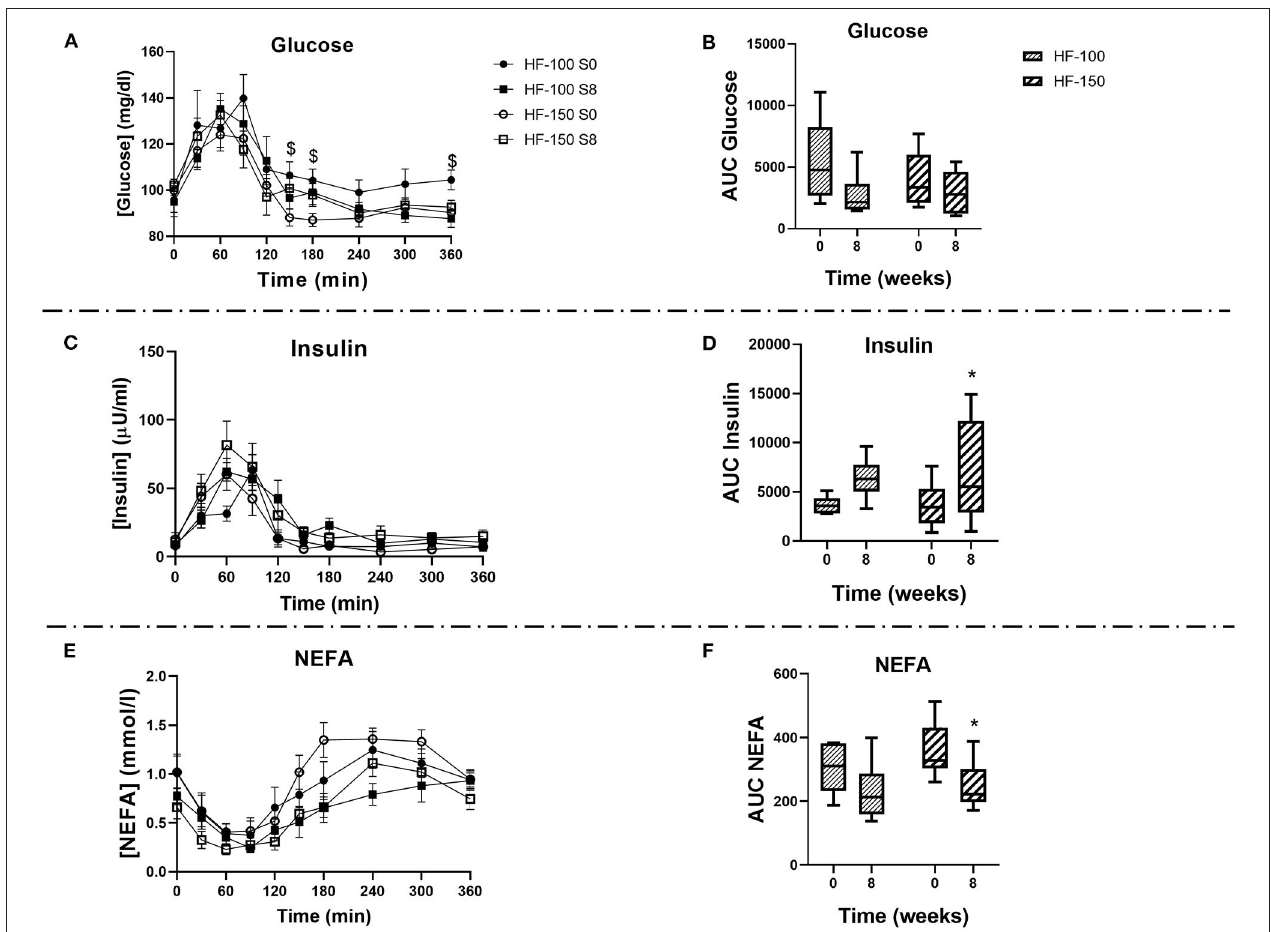
FIGURE 7 | (A) Plasma glucose, (C) Plasma insulin (E) , and Plasma NEFA concentrations, and the respective areas under the curves (B,D,F) during a feed-challenge test in dogs fed the high-fat diet at maintenance (HF-100; n = 8) or at 150% maintenance (HF-150; n = 8) for 8 weeks. Data are mean ± SEM or median (range min-max). $ P < 0.05 HF-150 vs. HF-100 for the same timepoint at week 0. * P < 0.05 at week 8 vs. week 0 for HF-150